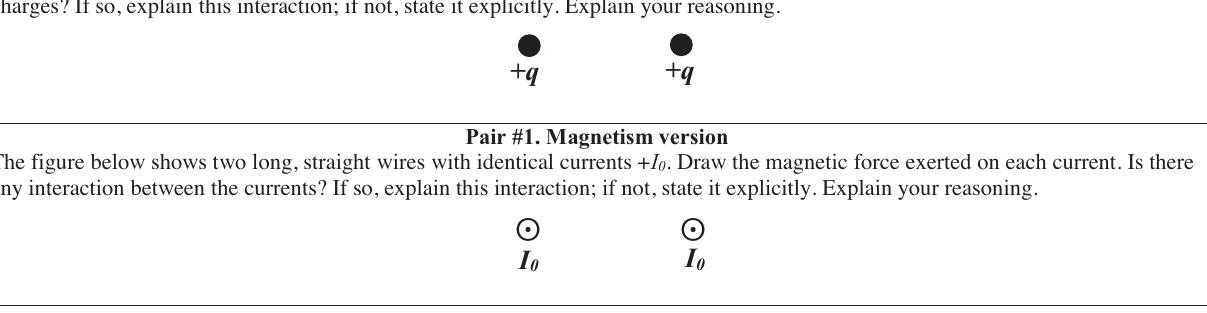
FIG. 1. Pair No. 1 of parallel items. In the electricity version ( E ), two identical, static positive charges þ q are presented. The magnetism version ( M ) presents two long cables with identical conventional electric currents I 0 with direction out of the page.